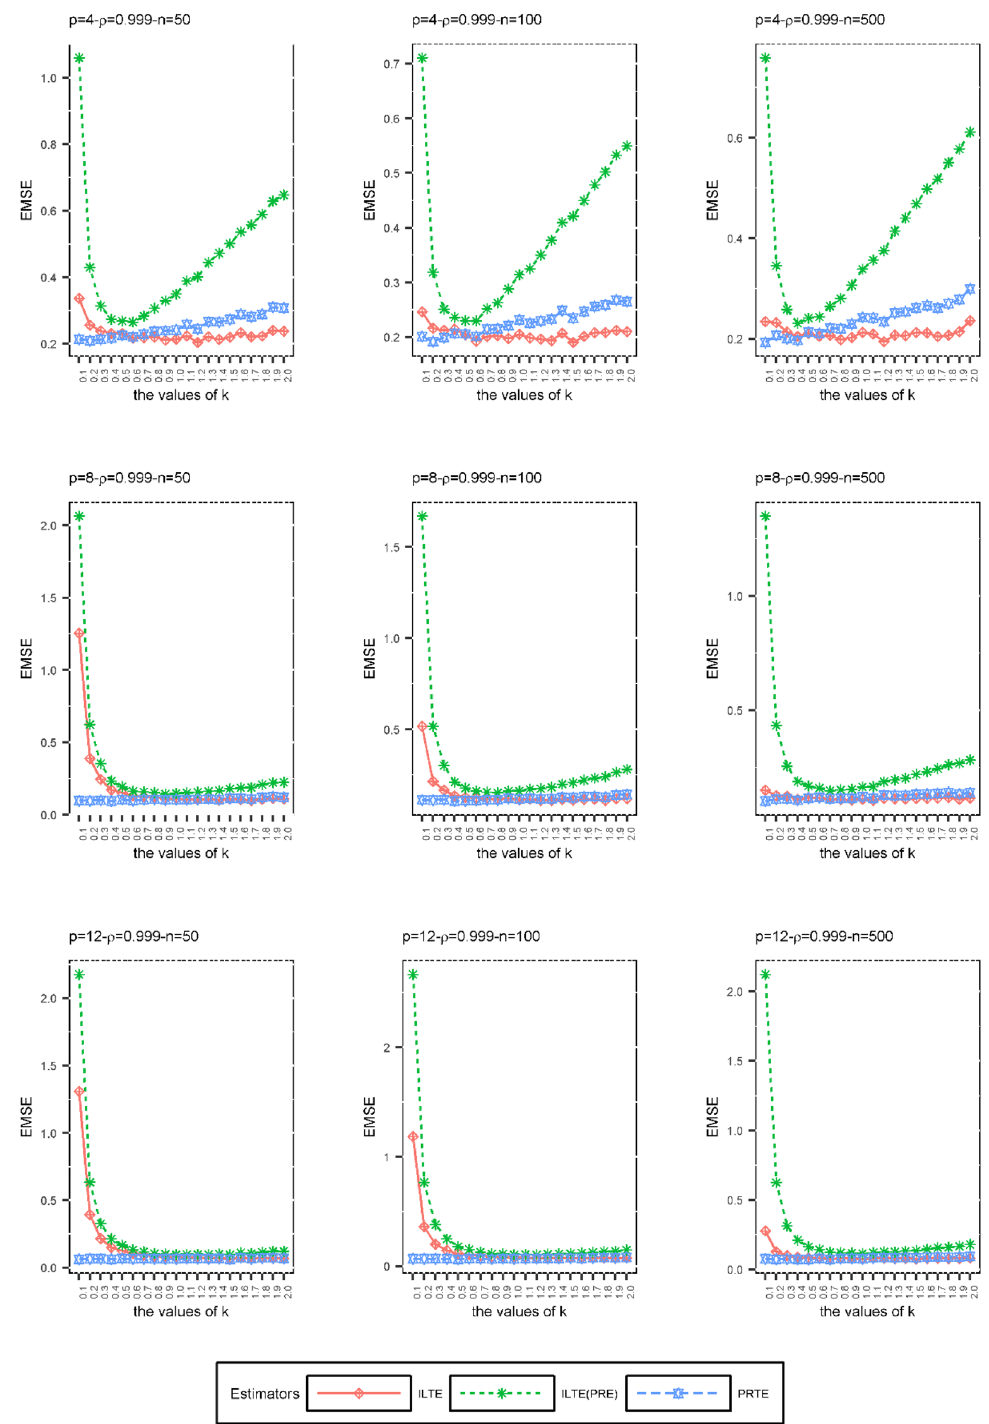
Figure 3. The EMSE values of ILTE, ILTE(PRE), PRTE as a function of k values where ρ = 0.999